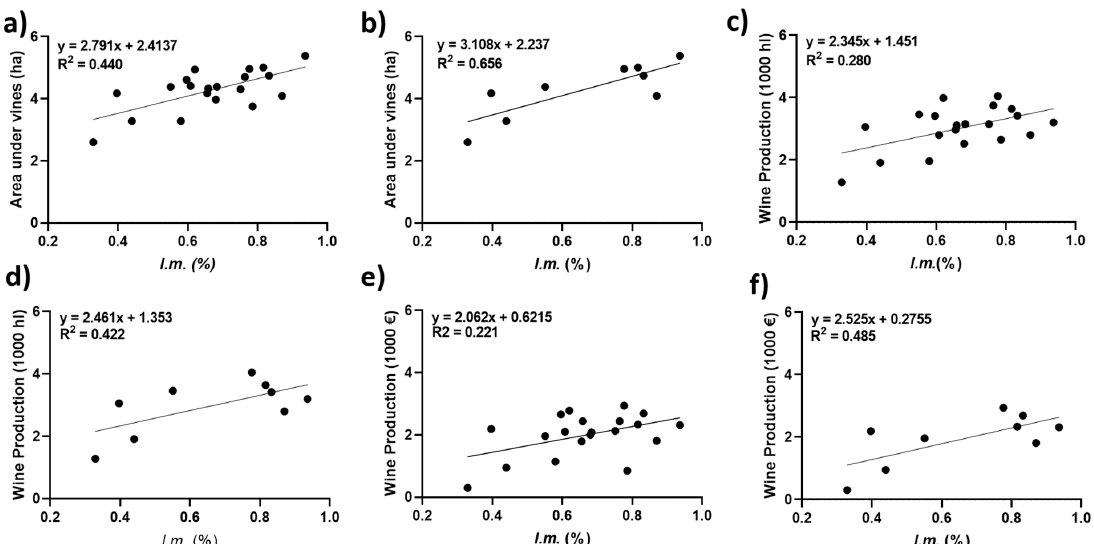
Figure 11. Correlation plots between the level of mechanisability ( l.m. ) and the area under vines for all regions ( a ) and selected regions ( b ), wine production expressed in volume for all regions ( c ) and selected regions ( d ), wine production expressed in value for all regions ( e ) and selected regions ( f ). Selected regions correspond to the ones identified in Figures 3 and 5. The R 2 and the equation are shown for each dataset. The representation is logarithmic.